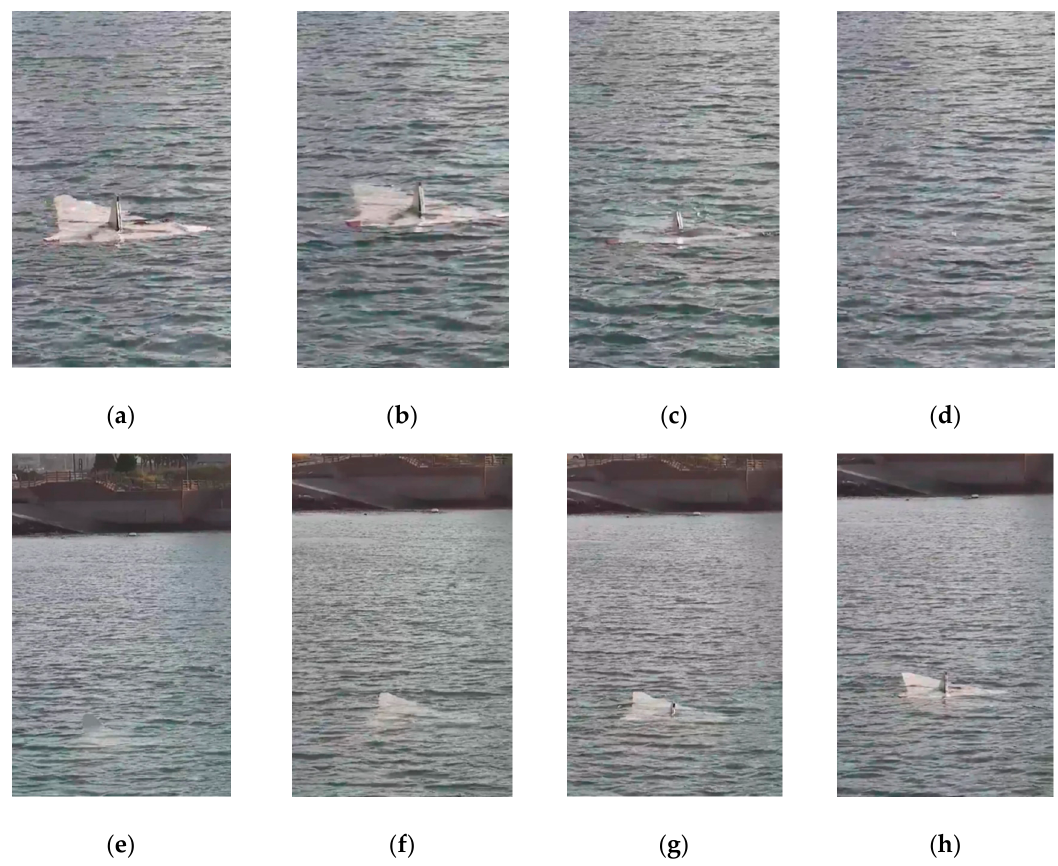
Figure 18. One cycle of gliding test in the sea: ( a – d ) descending motion and ( e – h ) ascending motion. Figure 19 shows the heading performance when using robust adaptive control during the sea trial. ◦ ◦ The heading angle was regulated at − 90 with an error of less than 4 . The yaw rate and virtual control input converged to around zero at the end of the experiment, which is good convergence. The control input of the robust adaptive heading control in the sea is shown in Figure